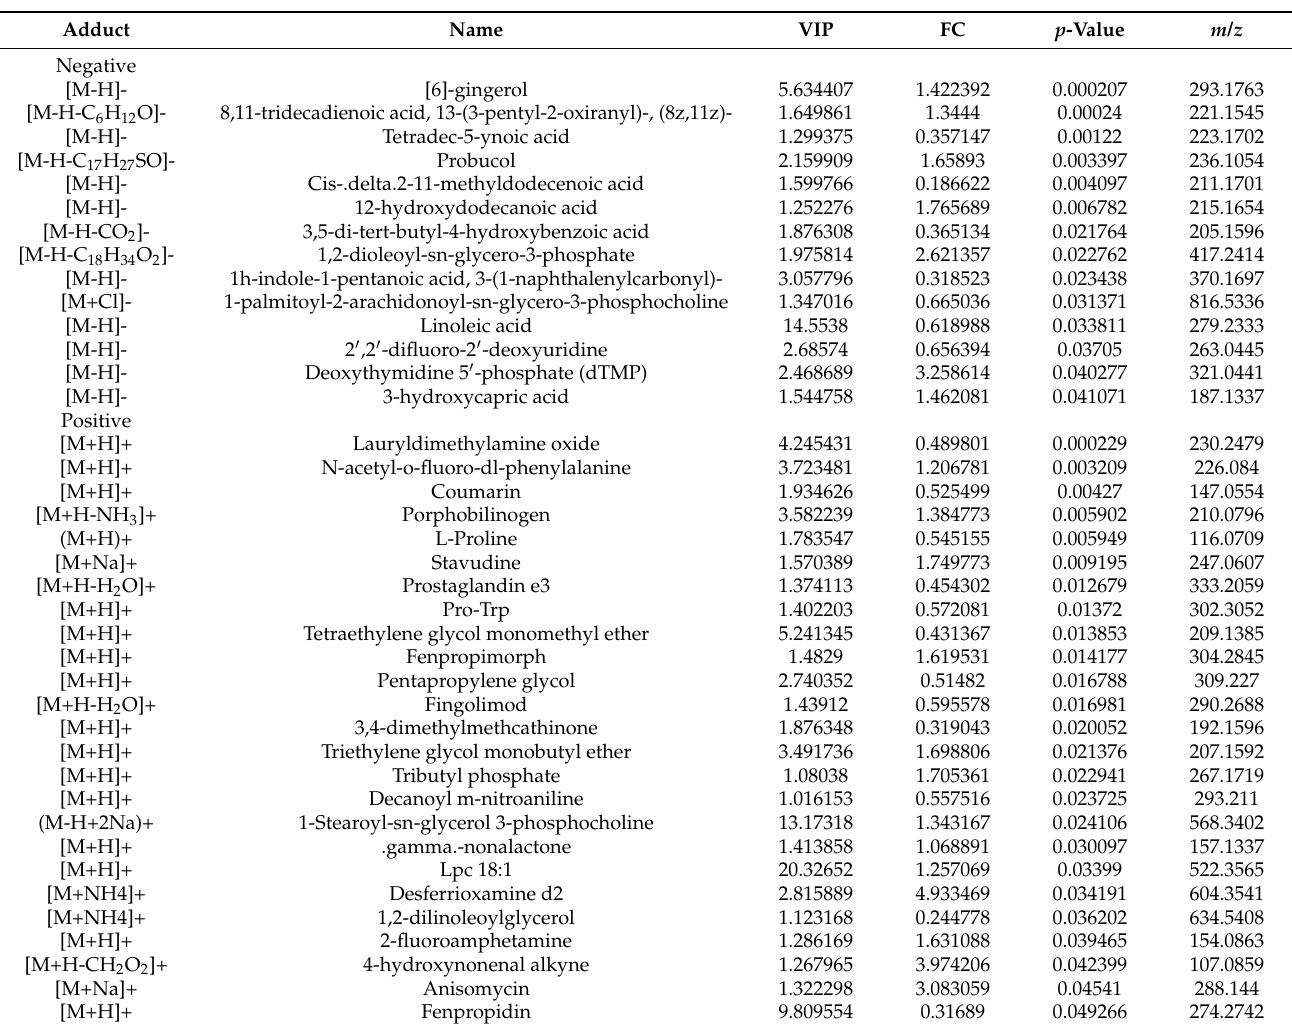
Table 2. Identification of differential metabolites between HFDFV and HFD under negative and positive ionization